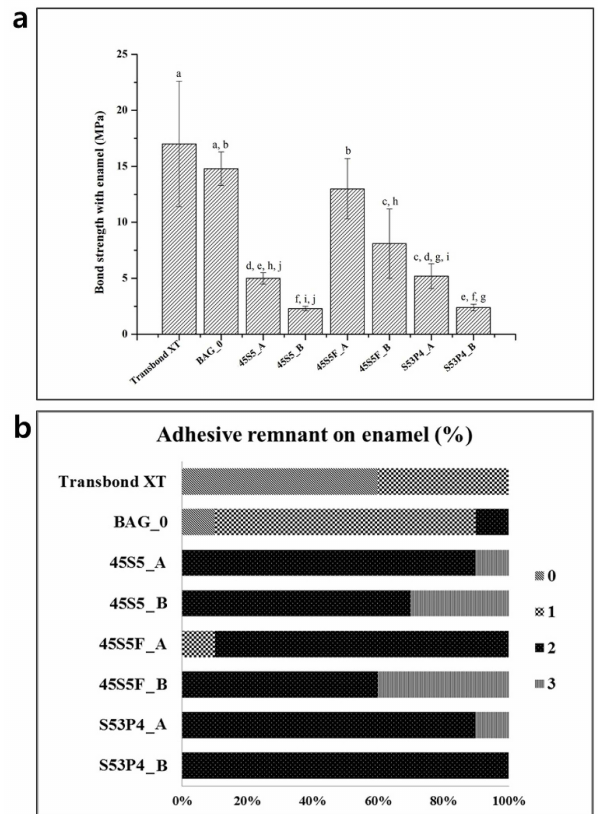
Figure 5. Shear bonding test for experimental orthodontic adhesive. ( a ) Mean and standard deviation for shear bond strength (SBS). The same letters indicate no statically-significant difference ( p > 0.05); ( b ) Adhesive Remnant Index (ARI) score (% of total) for the debonded enamel surface. ARI scores: 0, no adhesive remaining on tooth; 1, less than 50% adhesive remaining on tooth; 2, more than 50% adhesive remaining on tooth; 3, all adhesive remaining on tooth.